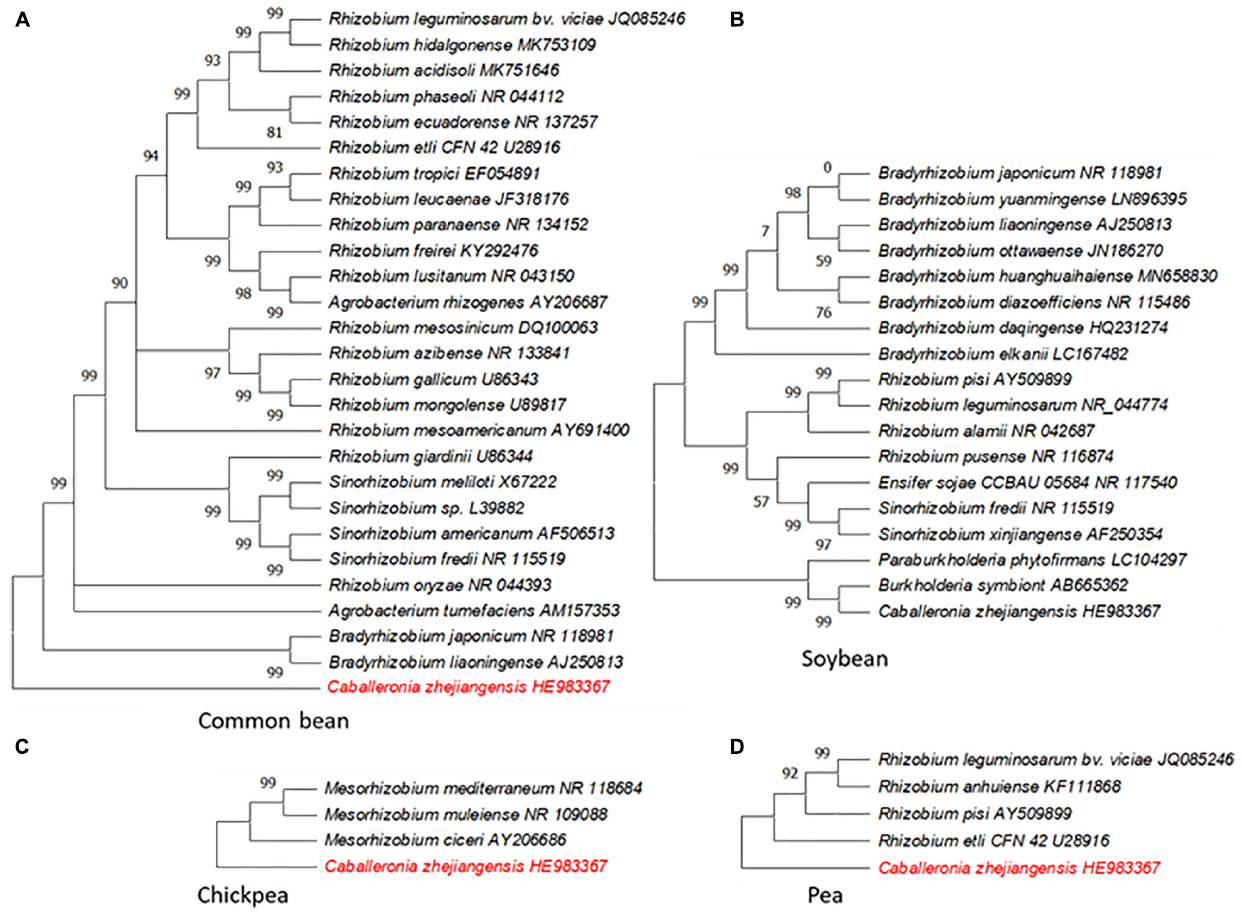
FIGURE 2 | Genetic diversity of rhizobia associated with different crops for biological nitrogen fixation. (A) Common bean. (B) Soybean. (C) Chickpea. (D) Pea. The phylogenetic trees of 16S ribosomal RNA of the rhizobial species known to nodulate the indicated crop species were constructed in MEGA X (Kumar et al., 2018) using the neighbor-joining method. Caballeronia zhejiangensis HE983367 displayed in red font in A, C , and D was used as a reference sequence in the analysis; this rhizobial species does not forge symbiosis with these